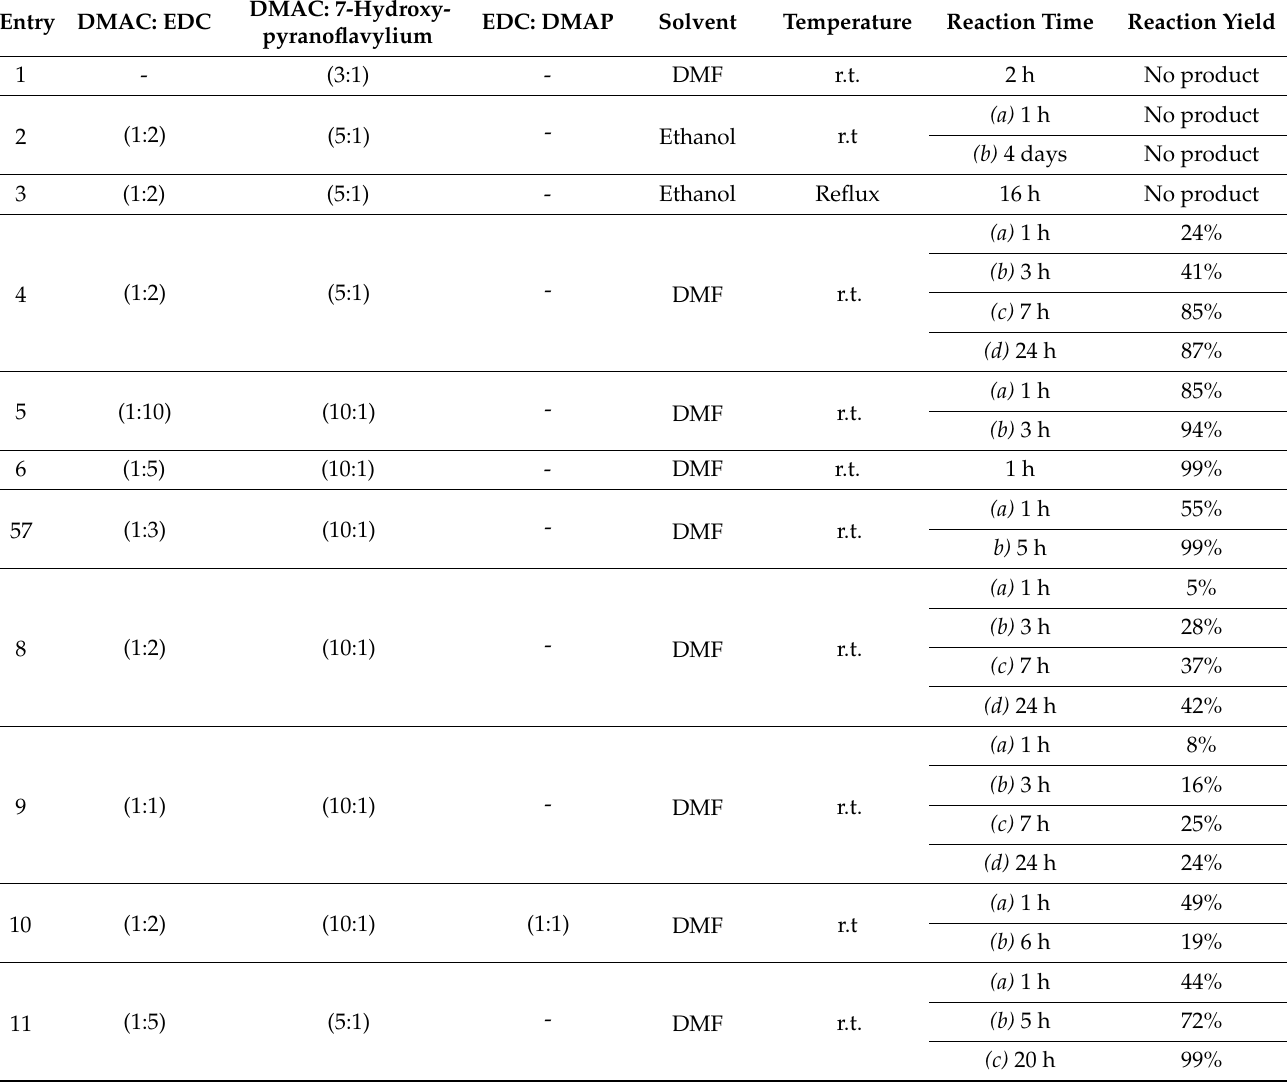
DMF—dimethylformamide, r.t. room temperature. The optimization process was performed for all cinnamic derivatives. In the function- alization with 4-dimethylamino cinnamic acid, a reaction yield of 99% was achieved,